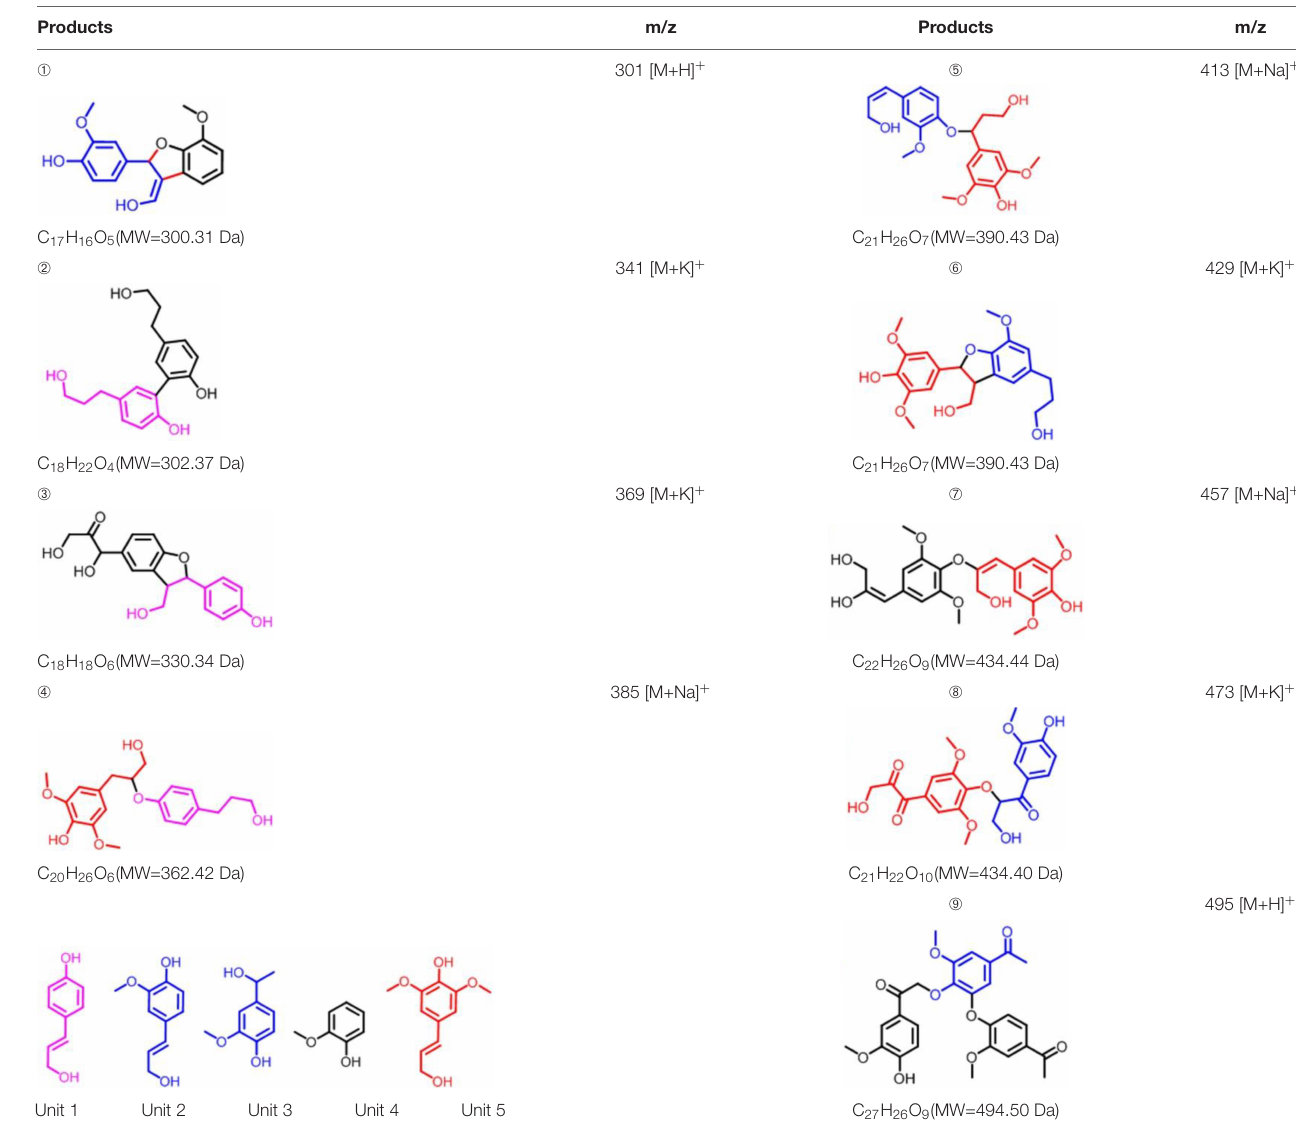
TABLE 1 | Estimated degradation products of Kraft lignin catalyzed by F43Y/T67R Mb based on the ESI-MS analysis. Products m/z